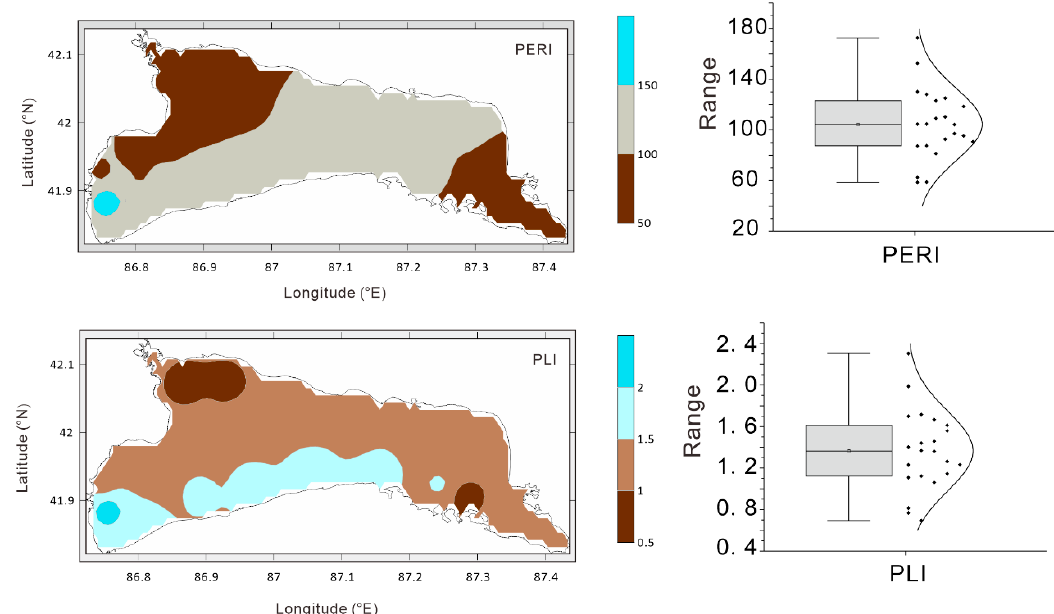
Figure 8. The pollution assessment of PTEs in the surface sediments of Lake Bosten.